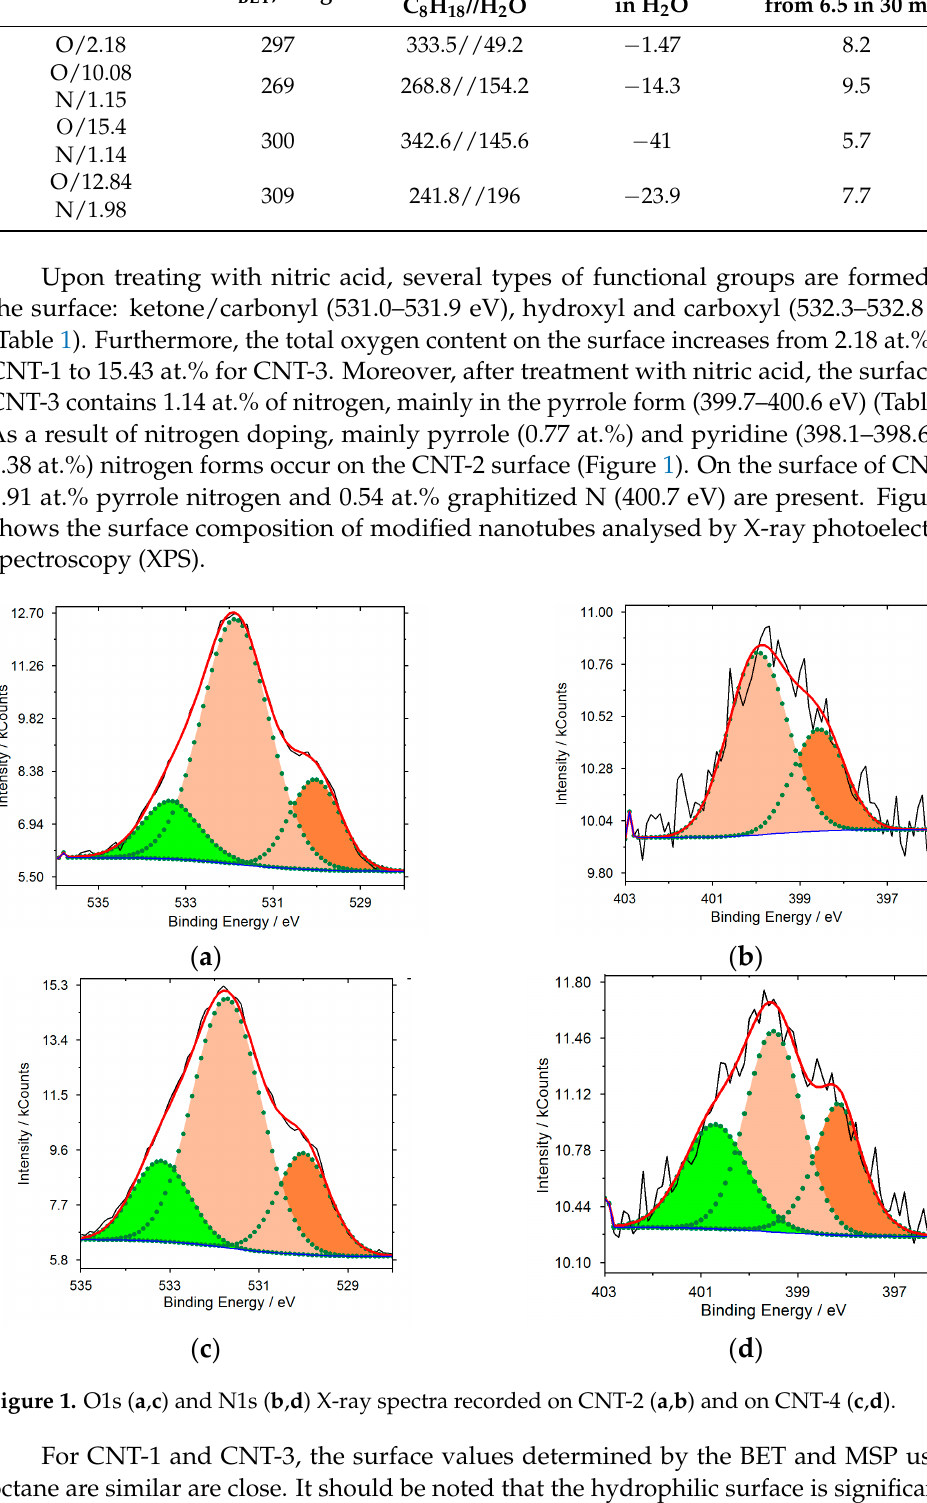
Table 1. Structural characteristics of surface and pH of studied CNT.